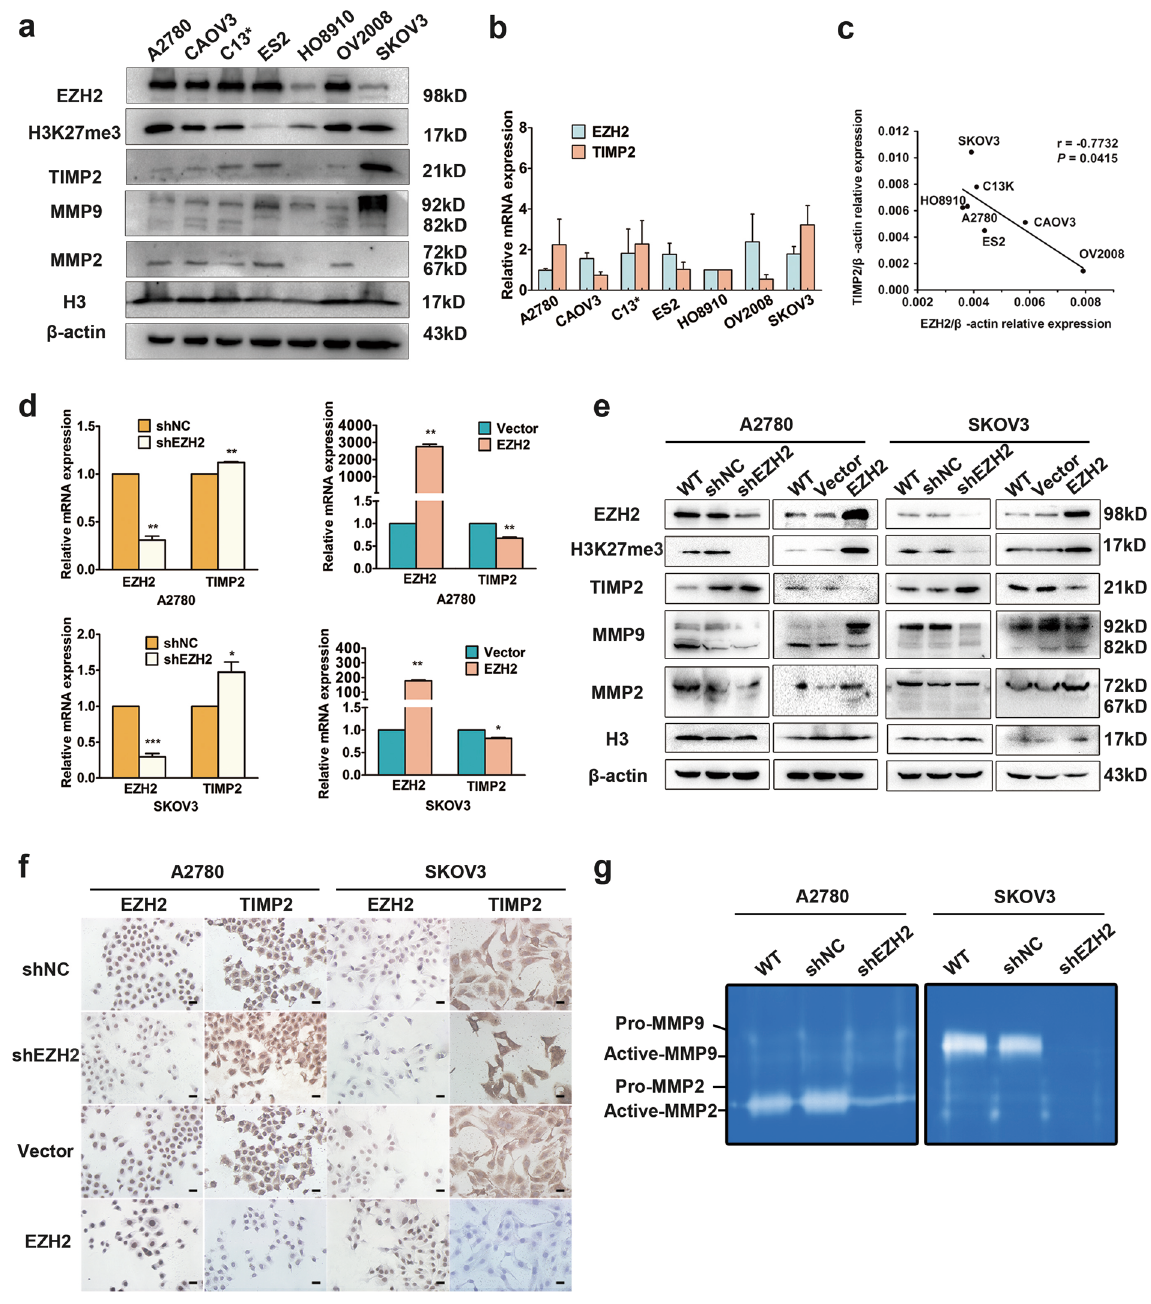
Figure 2. EZH2 regulates TIMP2 expression in vitro . ( a ) Western blot analysis of EZH2, TIMP2, MMP2, and MMP9 protein expression in ovarian cancer cell lines. Histone-3 (H3) and β -actin serve as internal controls. The cropped blots are used in the figure, and full-length blots are presented in Supplementary Fig. S5. ( b ) EZH2 and TIMP2 mRNA expression levels in seven ovarian cancer cell lines were detected by quantitative real-time PCR. ( c ) Negative correlation between TIMP2 and EZH2 mRNA levels in ovarian cancer cell lines. ( d ) qRT-PCR for EZH2 and TIMP2 expression in A2780 and SKOV3 cells with EZH2 up- or down-regulation by transfection with an EZH2-overexpressing plasmid (EZH2) or targeting shRNA (shEZH2). ( e ) Western blot analysis of EZH2, TIMP2 and MMP2/9 protein expression in EZH2-regulated A2780 and SKOV3 cells. Histone-3 (H3) and β -actin are used as internal controls. The cropped blots are used in the figure, and full-length blots are presented in Supplementary Fig. S6. ( f ) Immunocytochemical staining of EZH2 and TIMP2 in EZH2-regulated A2780 and SKOV3 cells (scale bar, 20 μ m). ( g ) Gelatin zymography assays of MMP2 and MMP9 activity in EZH2-regulated A2780 and SKOV3 cells. The cropped gels are used in the figure, and full-length gels are presented in Supplementary Fig. S7. * P < 0.05; ** P < 0.01; *** P <